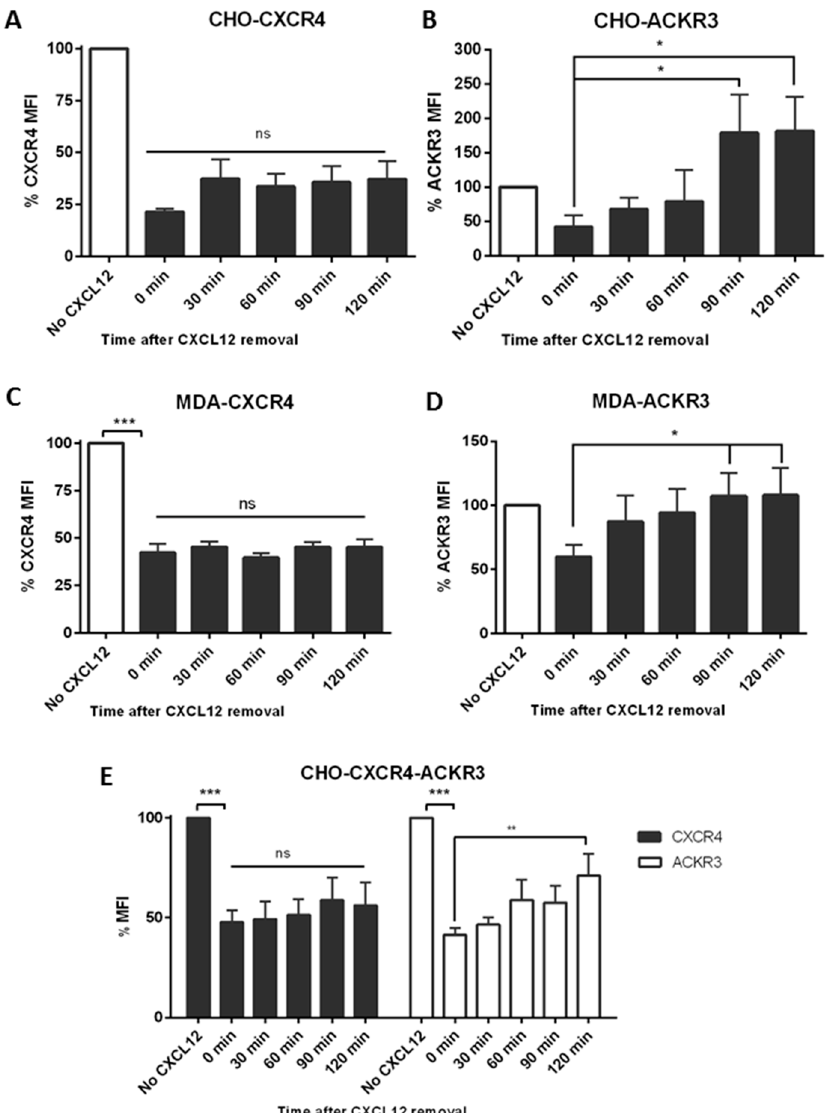
Figure 4. CXCR4 and ACKR3 follow different internalization pathways after CXCL12 stimulation. ( A ) CHO-CXCR4, ( B ) CHO-ACKR3, ( C ) MDA-MB-231-CXCR4, ( D ) MDA-MB-231-ACKR3 and ( E ) CHO-CXCR4-ACKR3 cells were treated with 10–50 nM CXCL12 for 15–30 min, then washed and incubated with chemokine-free media for up to 2 h to assess receptor recycling. Cells were labelled with CXCR4-PE and/or ACKR3-APC antibody and receptor’s mean fluorescence intensity (MFI) was measured using flow cytometry. Data represents the mean ± SEM of three independent